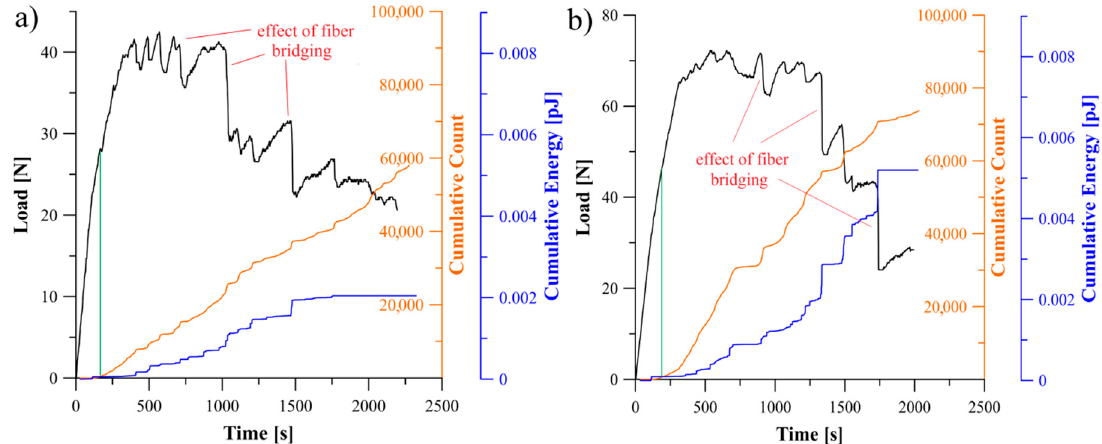
Figure 5. Relation between load, cumulative count and energy of AE signal obtained during the DCB experiment: ( a ) for specimen exhibiting the bending-twisting elastic coupling, ( b ) for specimen with 60°//60° delamination interface.